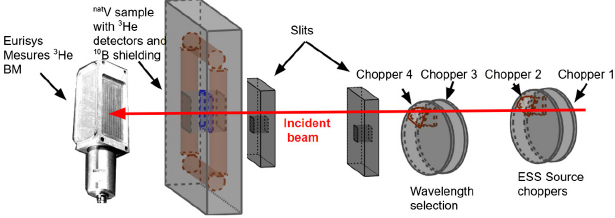
link.FIG. 7. Experimental setup at V20 beam line. The incident beam (red) passes from right to the left through two sets of choppers and 2 sets of (x,y) slits before striking the nat V sample (blue). The slightly attenuated beam is monitored with a reference Eurisys Mesures 3 He beam